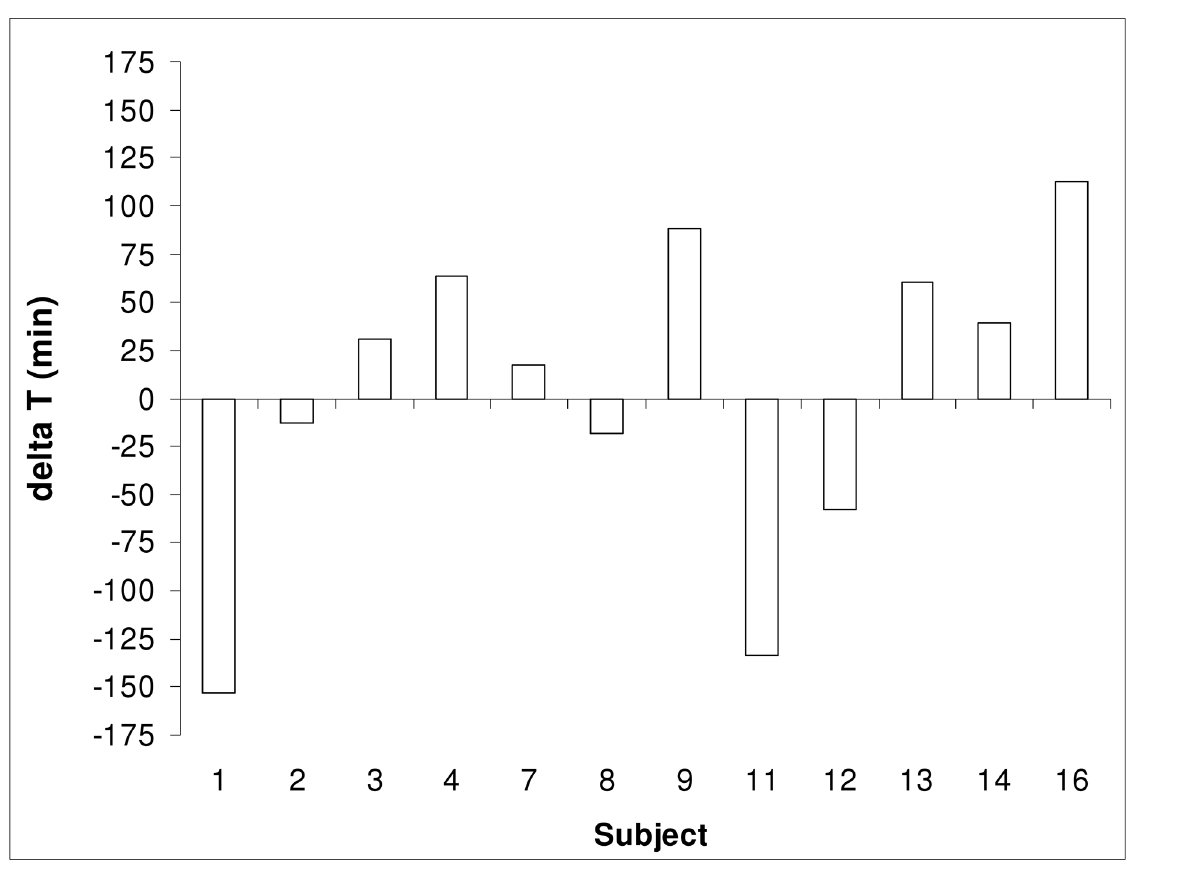
Fig 6. Difference (delta T) between lag-time (based on isotope signal) and CAT (based on pH) for each subject (n =